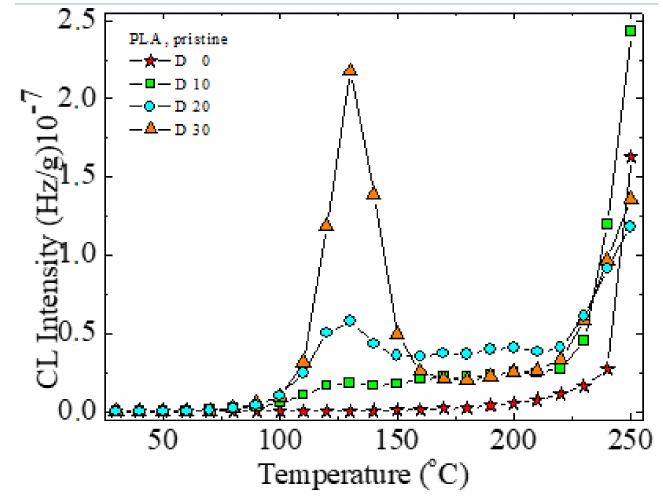
Figure 11. Non-isothermal CL spectra for degrading PLA subjected to various gamma irradiation doses.